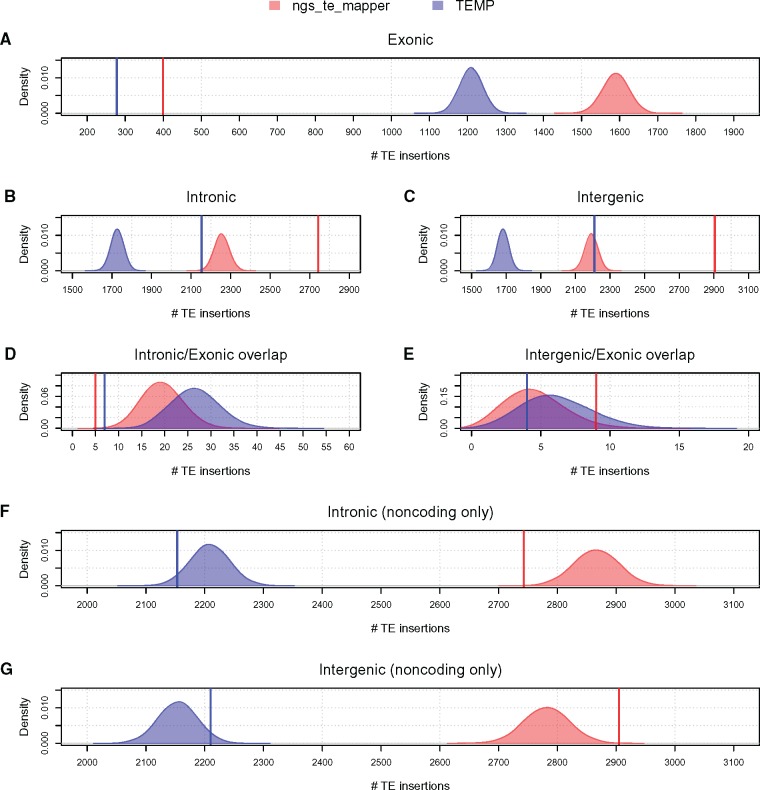
—TEs in normally recombining regions of the Drosophila melanogaster genome are depleted in exonic and intronic regions. Observed numbers of TEs in different genomic compartments are shown as vertical lines for ngs_te_mapper (red) and TEMP (blue). Empirical null distributions of the numbers of TEs in different genomic compartments in 10,000 random permutations are shown as density plots for ngs_te_mapper (red) and TEMP (blue). All permutation analyses were restricted to normally recombining regions of the D. melanogaster genome as defined by Cridland et al. (2013). Permutation analyses were conducted across all compartments (A–E), or in noncoding regions only (F and G). Observed and simulated numbers of TEs were counted in exonic regions (A), intronic regions (B and F), intergenic regions (C and G), intronic/exonic boundaries (D), and intergenic/exonic boundaries (E). Observed TEs overlapping intron/exon boundaries or intergenic/exon boundaries were excluded from permutation analyses in noncoding regions only (F and G). Regions of the reference genome identified by RepeatMasker as TE sequence and any nonreference TE in these regions were also excluded from all permutation analyses.